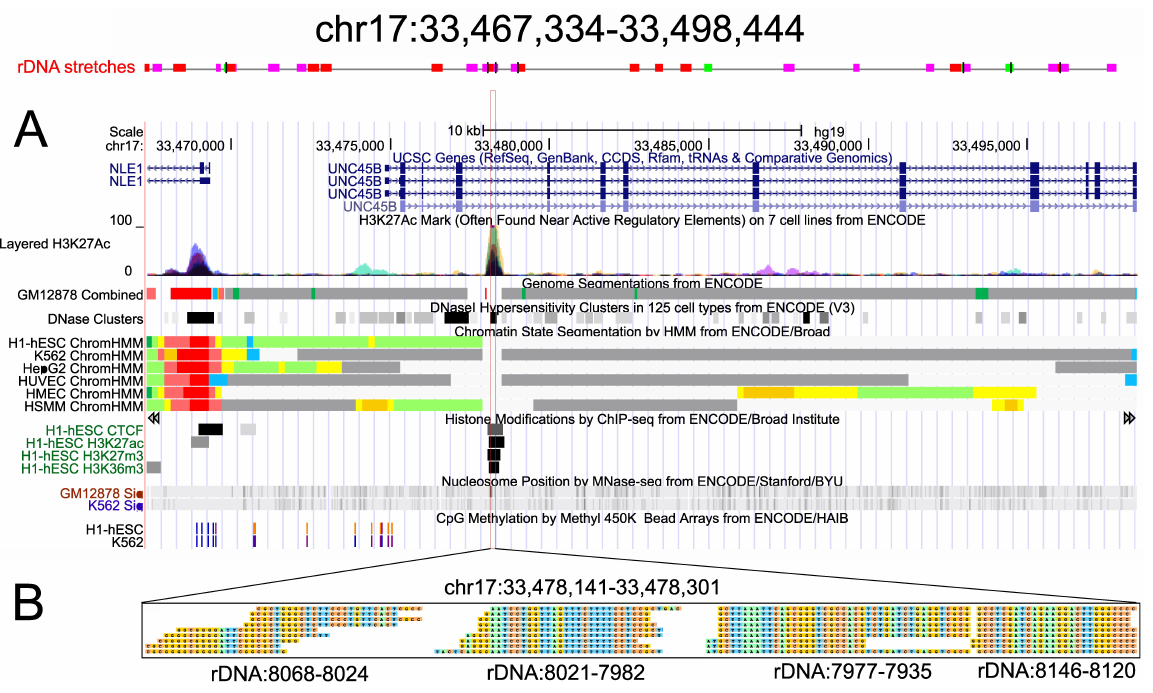
Figure 2. Characterization of srRNA targets inside the intron of the UNC45B gene. ( A ) Divergent rDNA stretches in the region are shown at the top. The colors indicate the alignment score of NCBI BLAST. The dot plot in Figure S1 shows the position of a short rearranged 5′ fragment of the 28S gene inside a segment of chr17. The distribution of layered H3K27ac marks, genome segmentation from ENCODE, histone modifications, nucleosome position, and CpG methylation inside a region of chr17 are shown as in the UCSC Browser. ( B ) Four groups of overlapping sequences of srRNAs of length 23–43 nt correspond to the main peak of sense srRNAs from the 28S gene, as shown in Figure 1B.